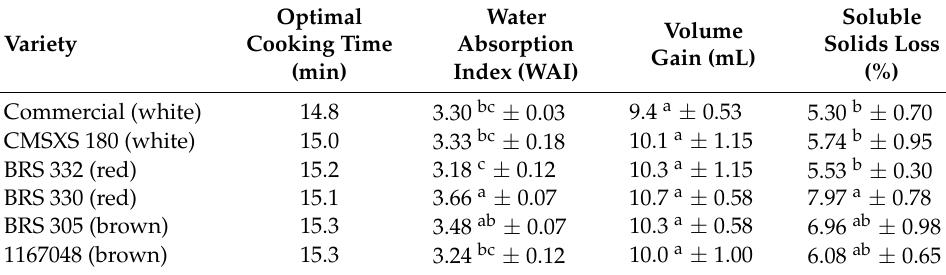
Table 3. Pasta cooking traits with sorghum flour as 50% of the starch